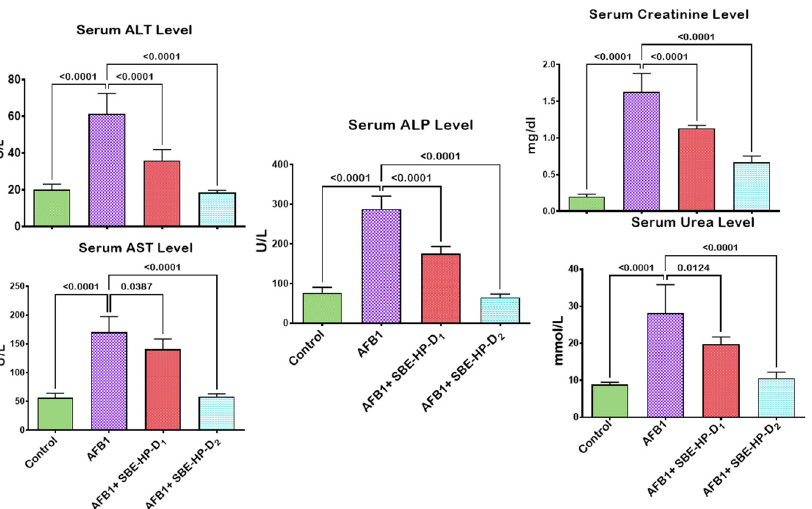
Figure 4. Effect of SBE-HP on the liver and kidney function of rats treated with AFB 1 for 28 d. Experimental doses: AFB 1 at 50 µg/kg; SBE-HP-D1 at 5 mg/kg; SBE-HP-D2 at 10 mg/kg. Values are expressed as mean ± SD for six rats per treatment cohort. Connecting lines indicate groups compared to one another. The significance level was set at ( p < 0.05); p < 0.05 suggests the level of significance; p > 0.05: not significant. AFB 1 : Aflatoxin B1; D1: lower dose; D2: higher quantity; ALT: Alanine aminotransferase; AST: aspartate aminotransferase, ALP: Alkaline phosphatase; GGT: gamma-glutamyl transferase.